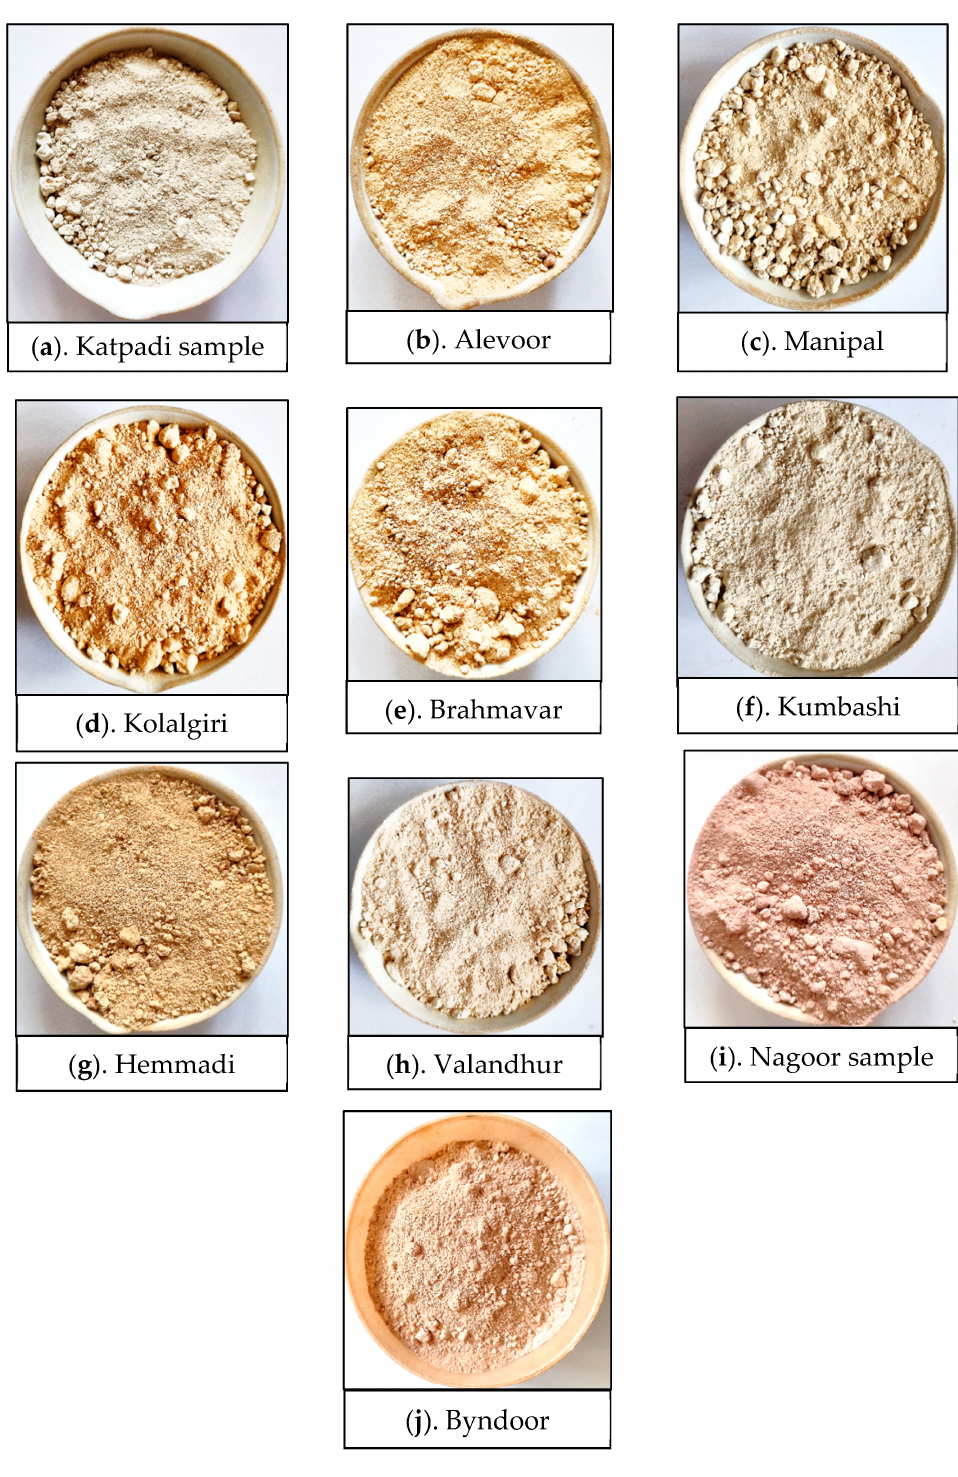
Figure 2. Samples from various locations in Udupi region.